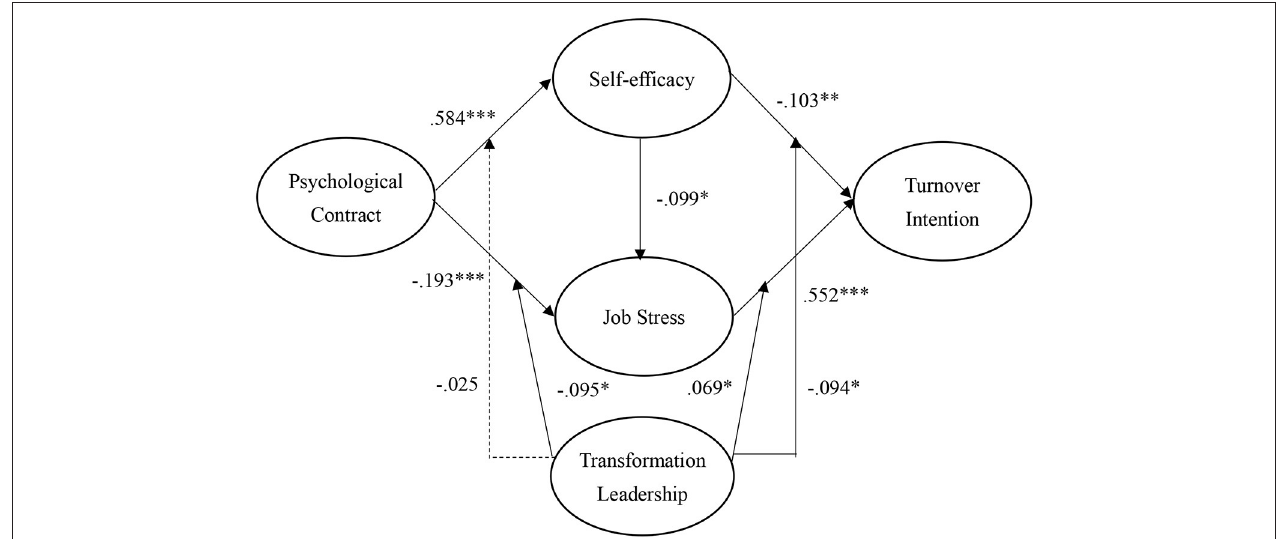
FIGURE 2 | Structural